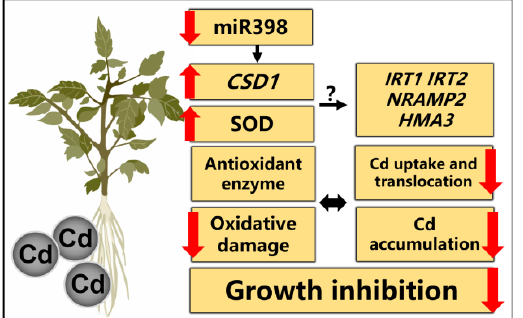
Figure 7. A schematic model of the role of miR398 in Cd stress acclimation in tomato.